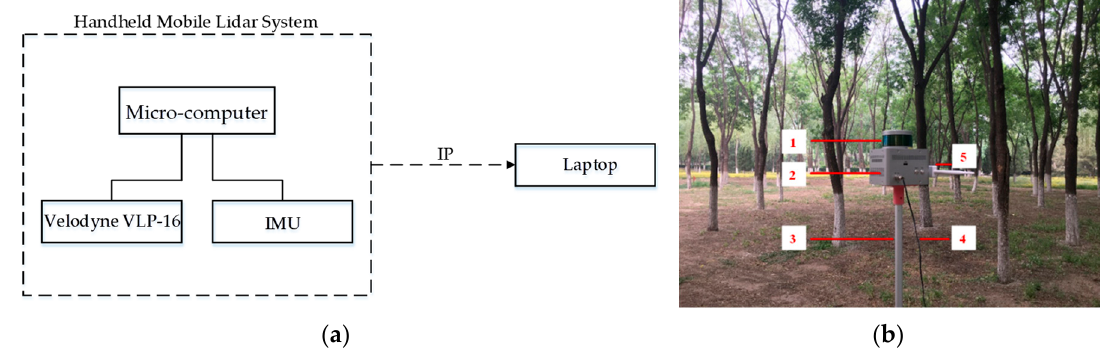
Figure 1. The mobile measurement system workflow chart and components. ( a ) System workflow chart; ( b ) system component. (1) Velodyne VLP-16 light detection and ranging (LiDAR); (2) encapsulated shell; (3) hand-held pole; (4) power cable; (5) wireless module.